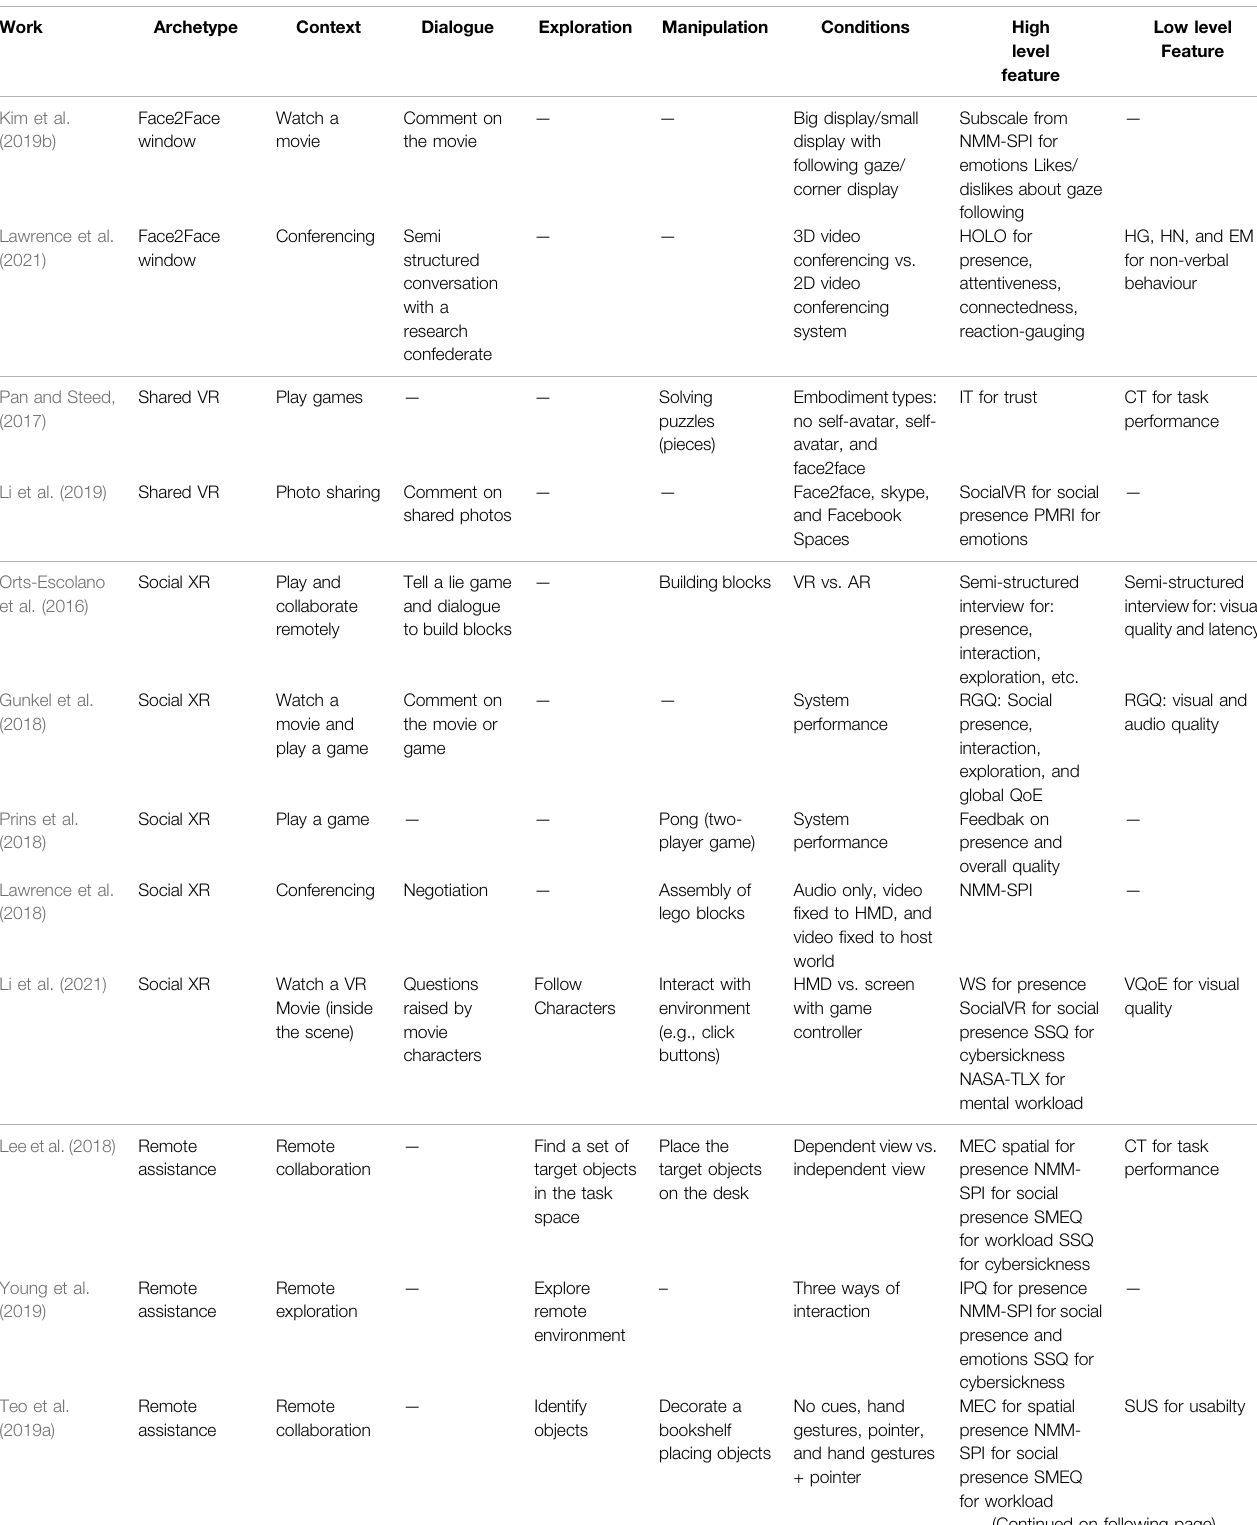
TABLE 3| Related workson QoE evaluation for thedifferentarchetypesystems. CTstands forCompletionTime;AEstands forAngular Error;HMfor HeadMovements, HG for Hand Gestures, HN for Head Nodes, EM for eye